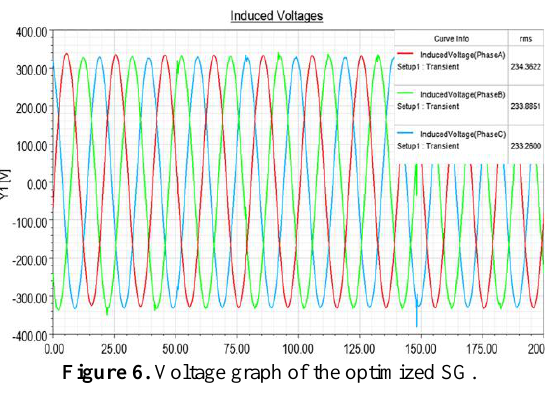
Figure 6. Voltage graph of the optimized